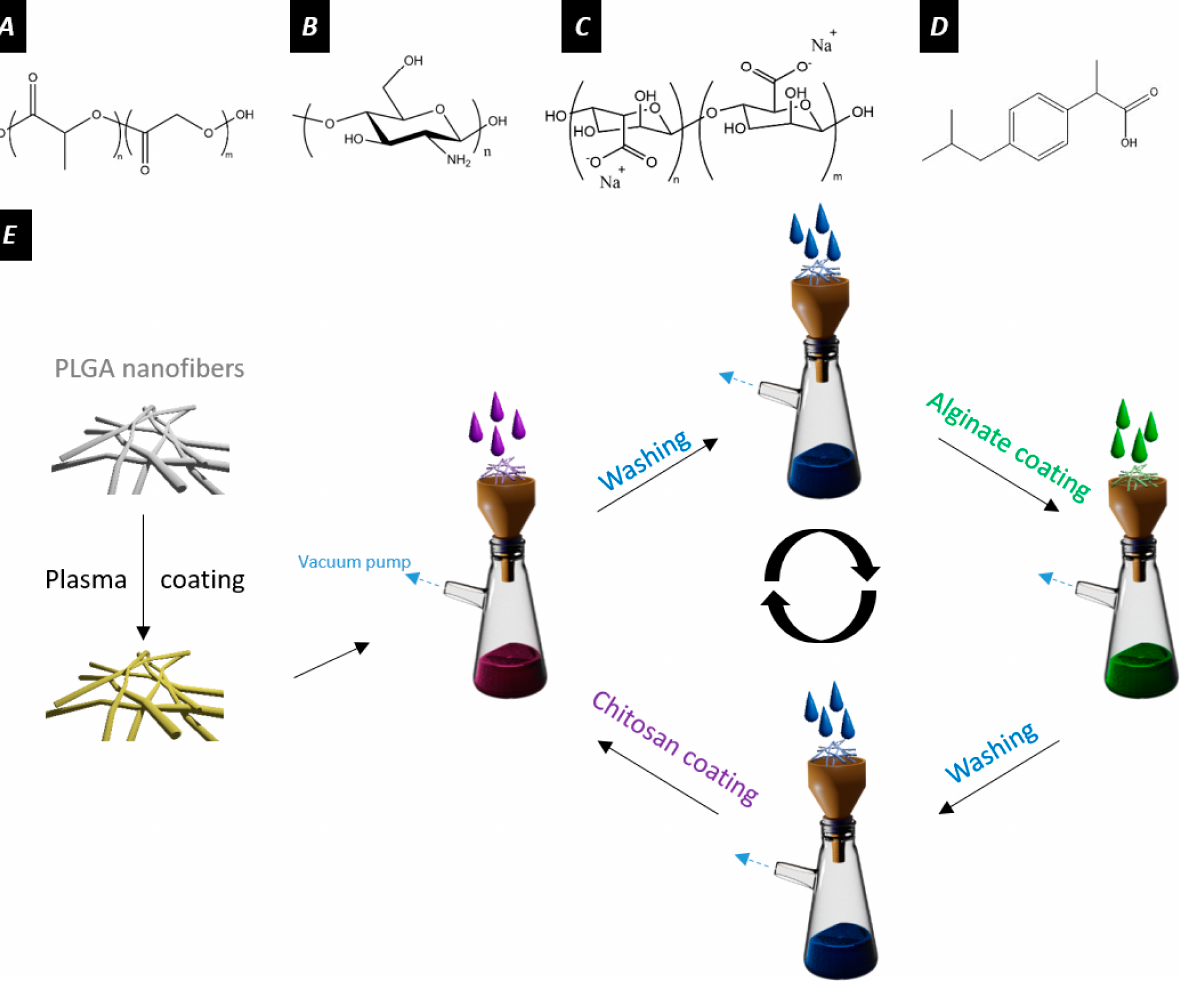
Figure 1. Chemical structures of ( A ) PLGA, ( B ) chitosan, ( C ) alginate, and ( D ) ibuprofen. ( E ) Summary of the LbL process for functionalizing the fibers. In this study, alginate and chitosan layers were alternatively deposited on the surface of plasma-coated electrospun nanofibers. The alginate and chitosan solutions are depicted in green and purple, respectively. Materials: PLGA with a ratio of 50/50 lactic acid to glycolic acid (Resomer RG505,